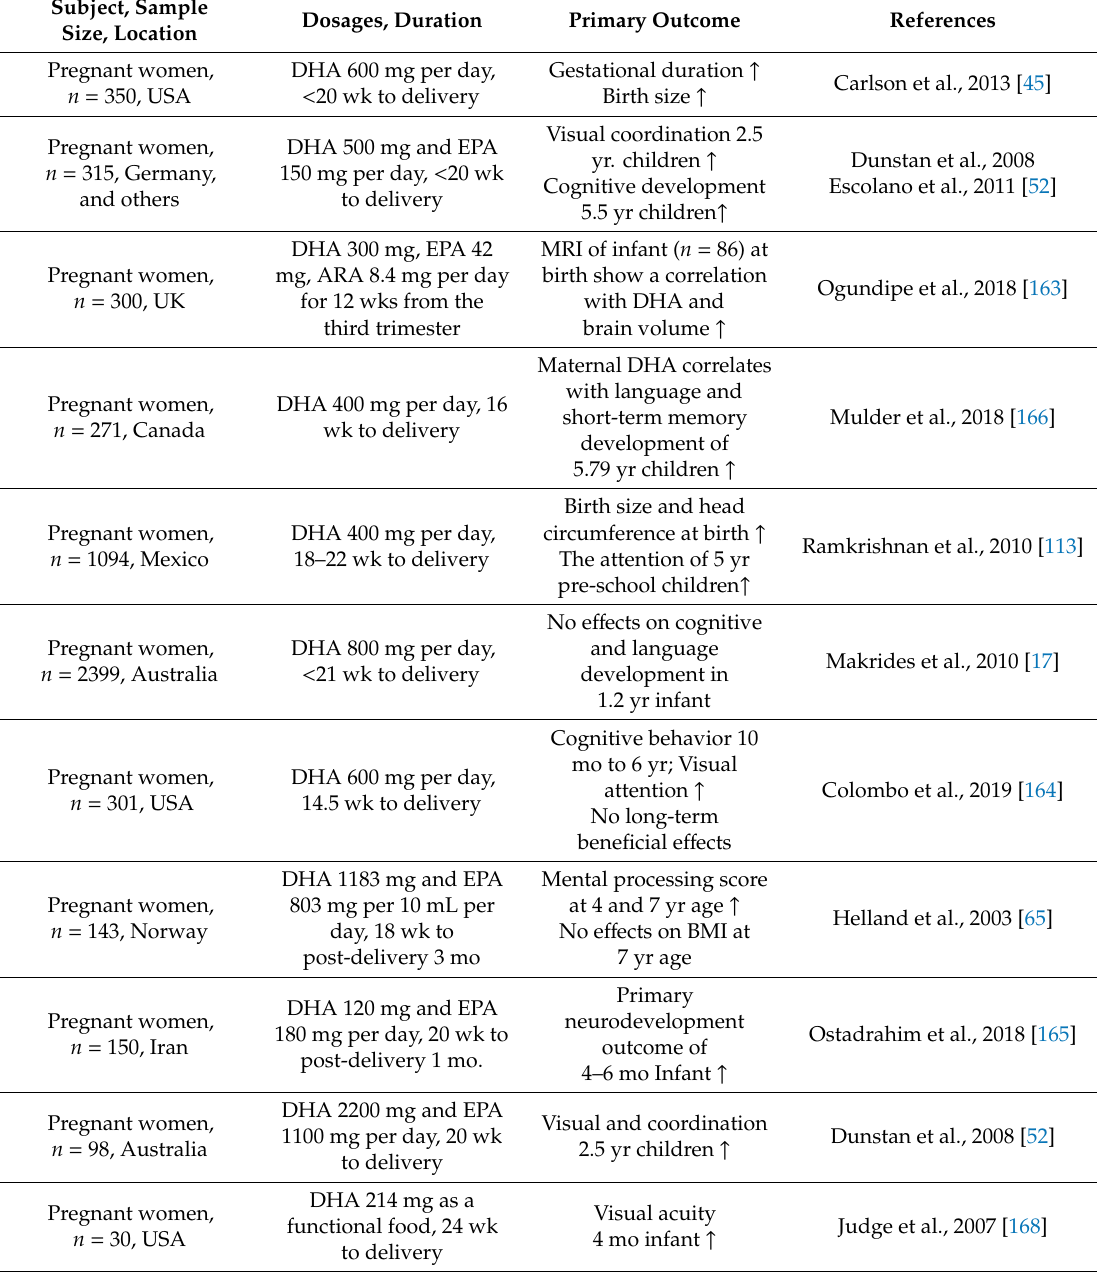
Table 1. Supplementation of DHA on the neonatal growth and cognitive development: a consolidated Randomized Controlled Trial